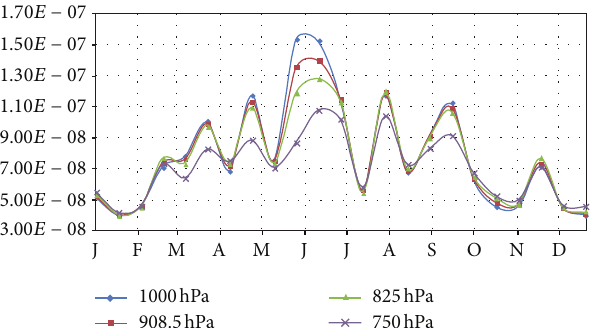
Figure 3: Time series for ozone measurements during 2007 concen- trating on four different pressure levels, 749hPa, 825 hPa, 908hPa, and 1000hPa, generated from TES, Aura.